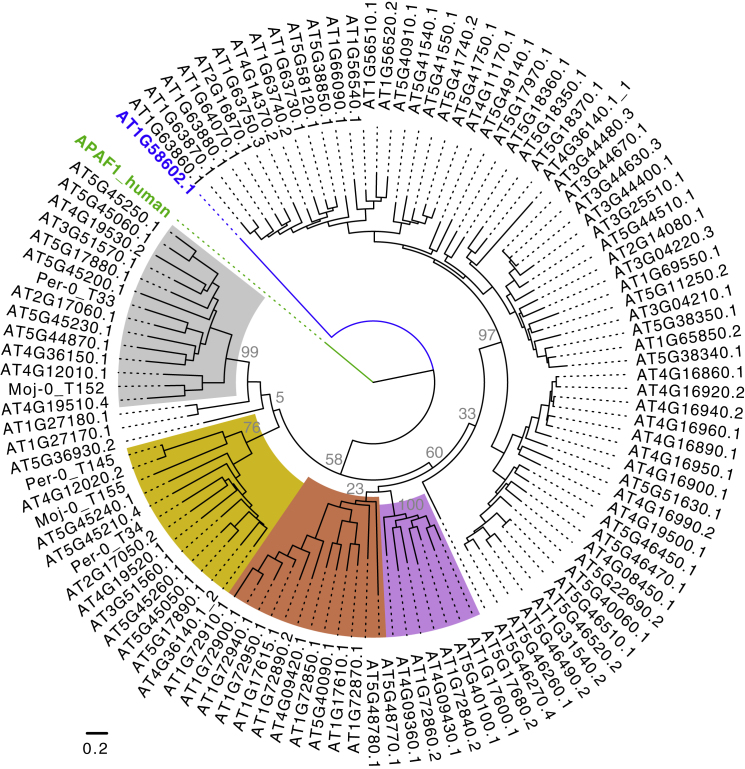
Phylogenetic Tree of NB Domain Alignments of TNLs to Delineate Sensor-Executor Pairs, Related to Figure 7The paired NLRs RPS4-like (executors, silver) and RRS1-like (sensors, gold) as well as SOC3-like (executors, light purple) and CHS1-like (sensors, brick) defined distinct subclades of TNLs. The NJ phylogeny was built from manually refined MUSCLE alignments of NB domains (∼240 amino acids) of Col-0 proteins plus selected additional representatives of OGs inferred to be paired, but absent from the Col-0 reference. NB domains from human APAF1 (green) and the A. thaliana CNL AT1G58602 (blue) were included as outgroups. The WAG maximum likelihood method allowing for 3 discrete Gamma categories was used. AT4G36140 contains two distinct NB domains, both of which were included; the second NB domain of AT4G36140 groups with other RRS1-like NB domains. Support from 100 bootstraps shown at major nodes. Scale bar indicates substitutions per site.